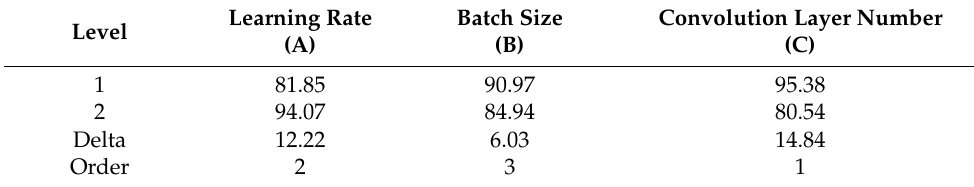
Table 5. Response level to the average